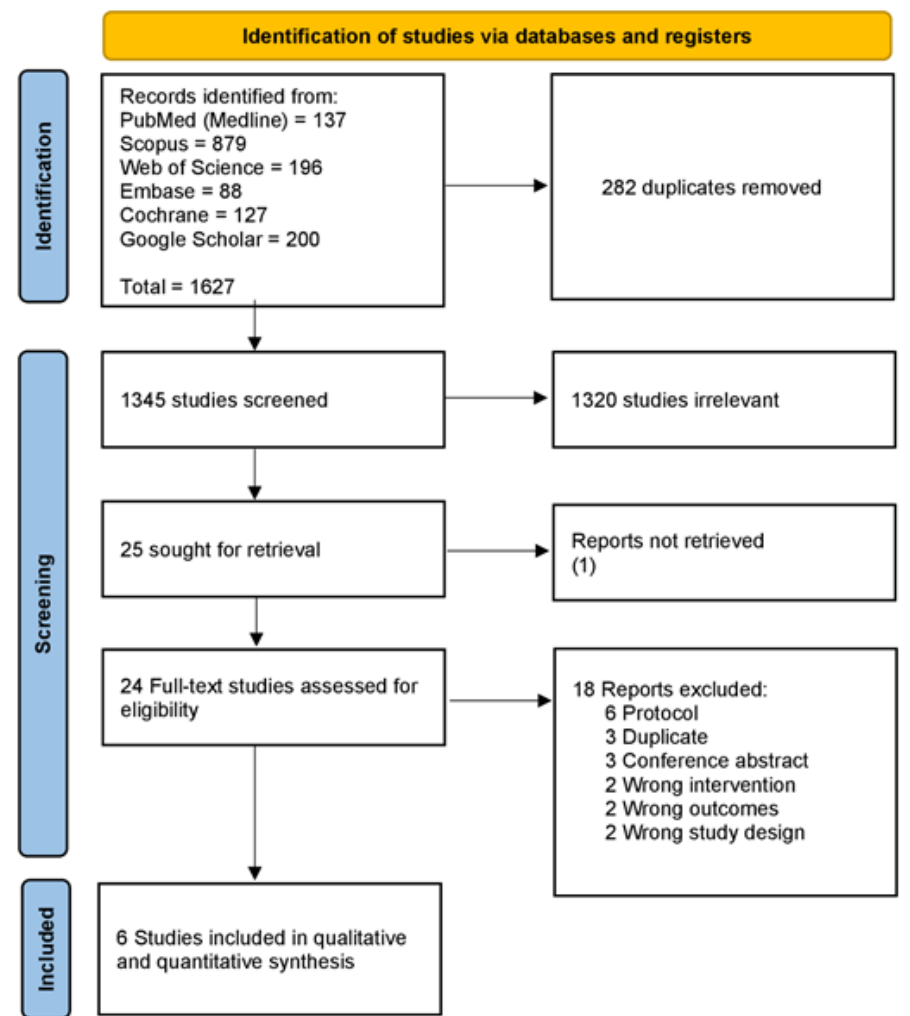
Figure 1. PRISMA flow chart of the screening process [33].